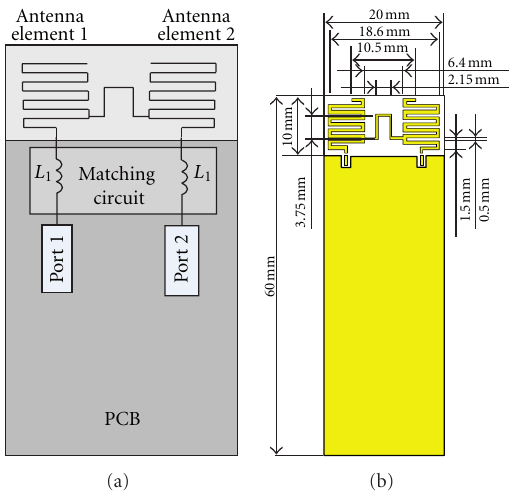
Figure 2: Structure (a) and CST Microwave Studio model (b) of the designed compact two-element MIMO antenna system #1.